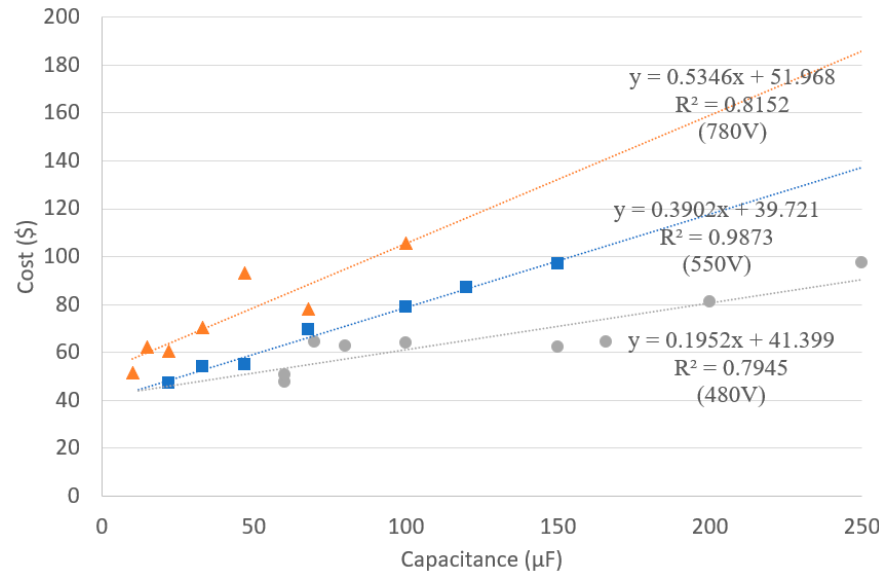
Figure 19. Cost model of film capacitor.